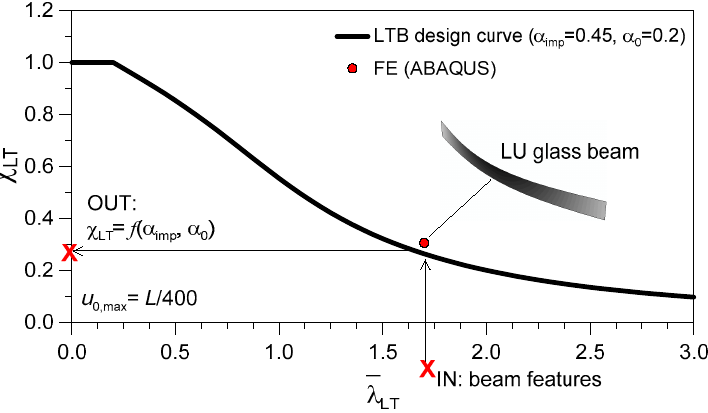
Figure 4. Standardized LTB design approach proposed in [25] for LU glass beams (with u 0,max = L / 400, the maximum amplitude of the reference sine-shaped imperfection).